Question: Express in one sentence what the figure is showing.
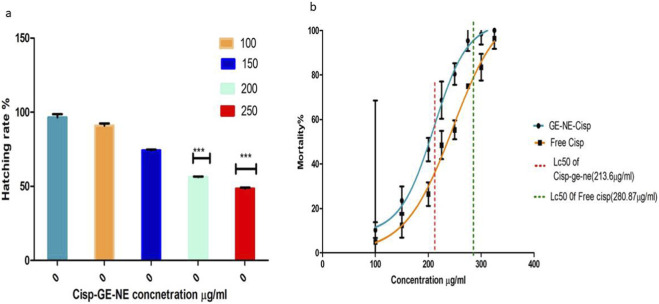
Answer: (a) Hatching rate of zebrafish embryos at 3 dpf following exposure to different concentrations of Cisp-GE-NE (100, 150, 200, and 250 μg/mL). A dose-dependent decline in hatching was observed, with significant reductions noted at concentrations ≥200 μg/mL. Data are presented as mean ± SD (n = 3 replicates). Statistical significance was analyzed, and values were compared to the control: ***p < 0.001. (b) Dose-response mortality curves for zebrafish larvae at 6 dpf treated with Cisp-GE-NE and free cisplatin. The LC 50 of Cisp-GE-NE was 213.6 μg/mL (red dashed line), while that of free cisplatin was 280.87 μg/mL (green dashed line), indicating enhanced toxicity of the nanoemulsion formulation. Data are shown as mean ± SD.